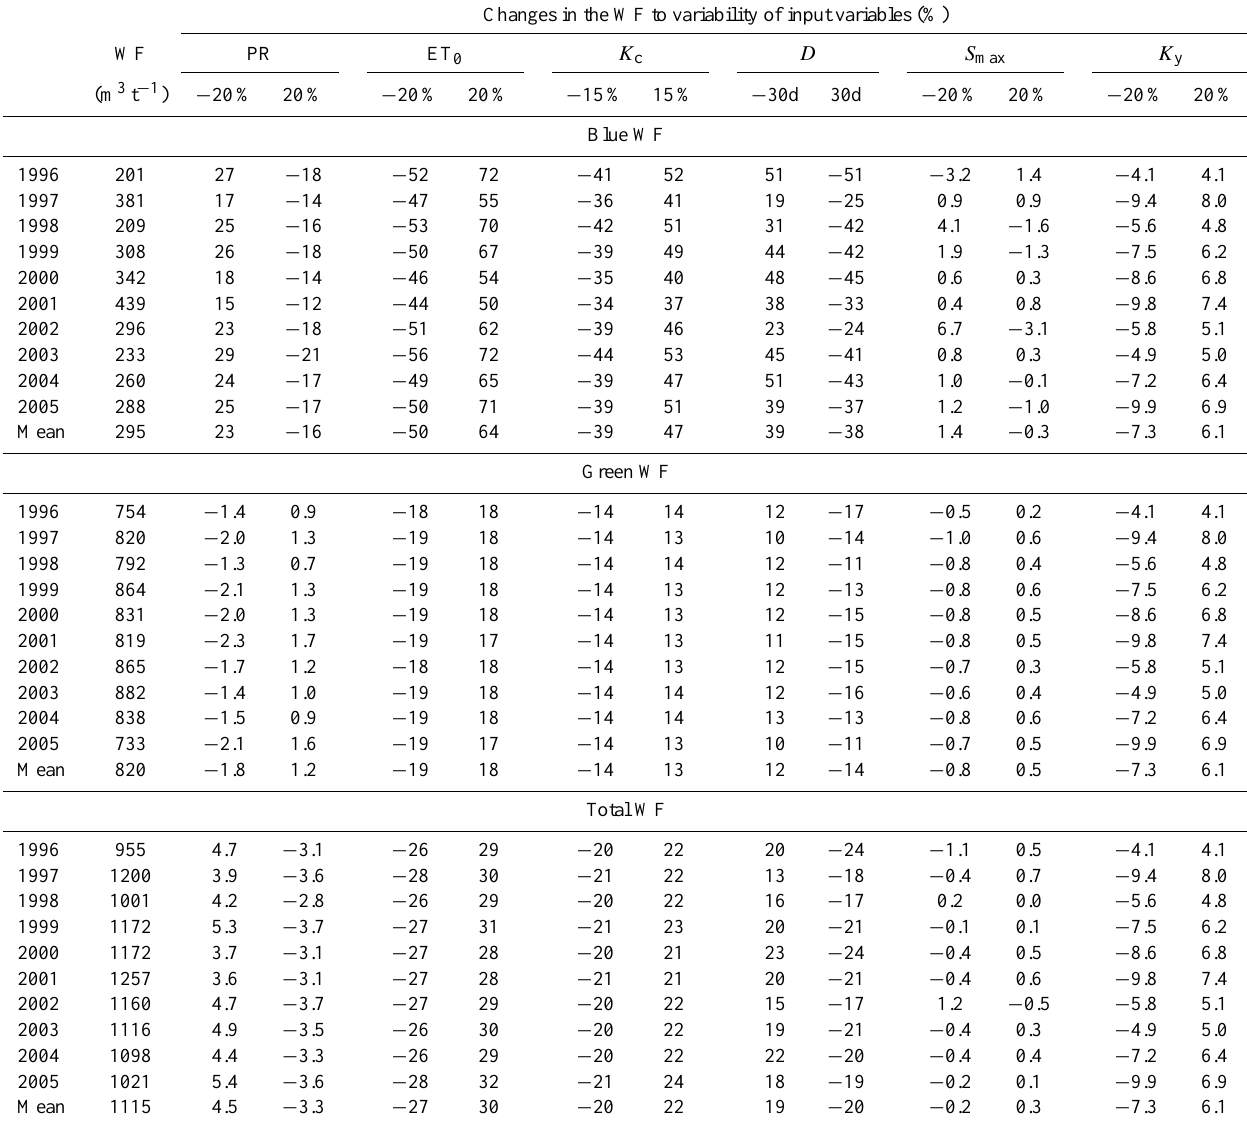
Table 3. Sensitivity of annual water footprint (WF) of maize to input variability at the level of the Yellow River basin, for the period